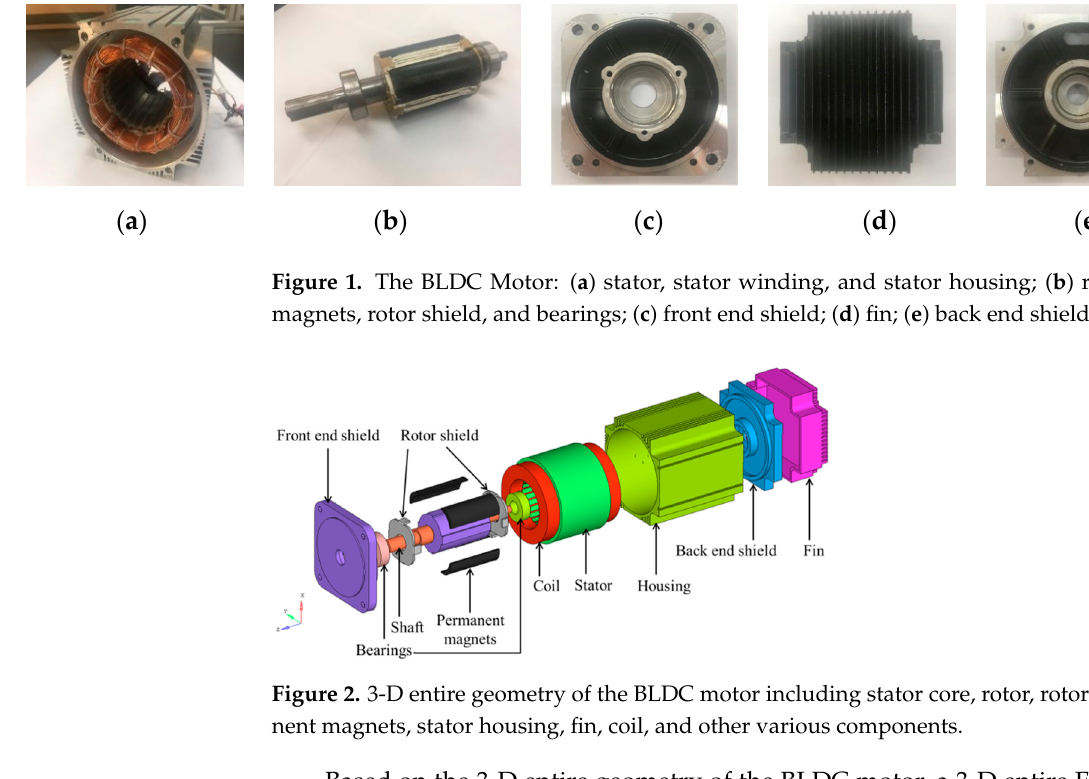
Figure 1. The BLDC Motor: ( a ) stator, stator winding, and stator housing; ( b ) rotor, permanent mag- nets, rotor shield, and bearings; ( c ) front end shield; ( d ) fin; ( e ) back end shield. Table 1. Parameters of BLDC motor.